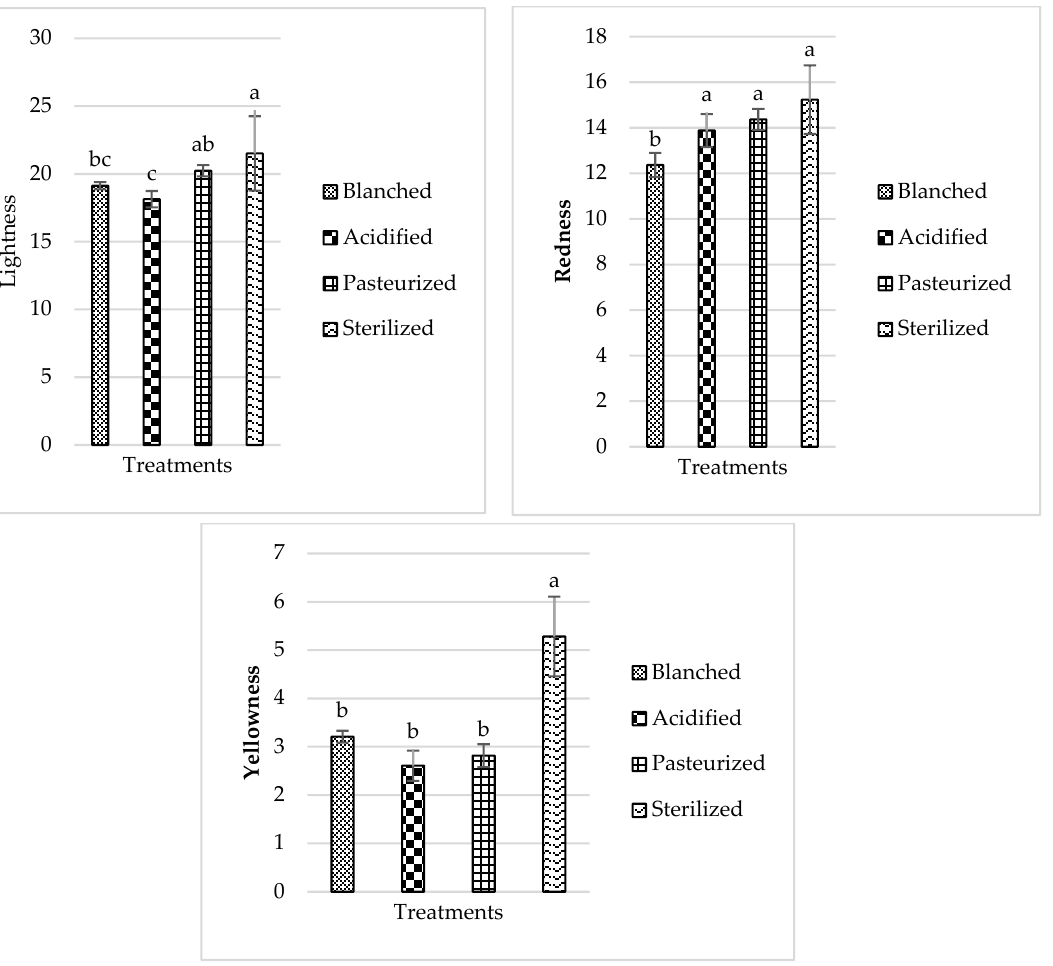
Figure 4. Lightness, redness and yellowness values of beetroot samples after different processing steps. Different letters indicate a significant difference ( p < 0.05).